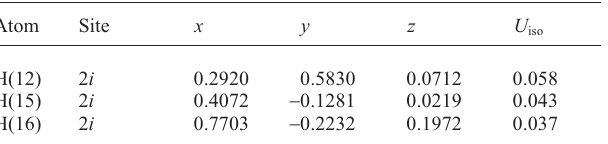
Table 3. Atomic coordinates and displacement parameters (in Å 2 )